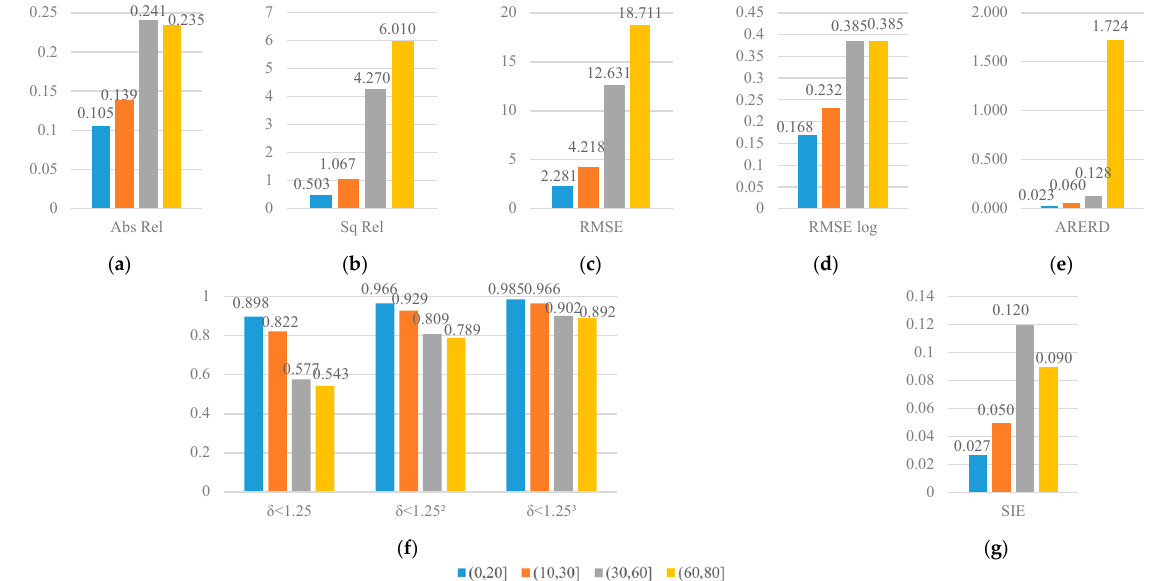
Figure 5. Quantitative comparison depth estimation precision in different depth ranges of the SFA-MDEN. ( a ) Abs Rel, ( b ) Sq Rel, ( c ) RMSE, ( d ) RMSE log, ( e ) ARERD, ( f ) accuracy metrics ( δ < 1.25, δ < 1.25 2 , δ < 1.25 3 ), and ( g ) SIE.